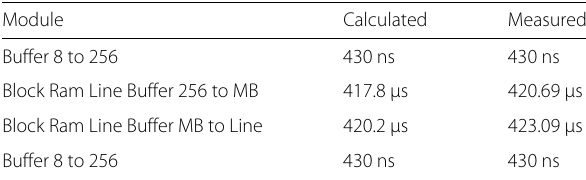
Table 3 Module time calculation vs time measure in